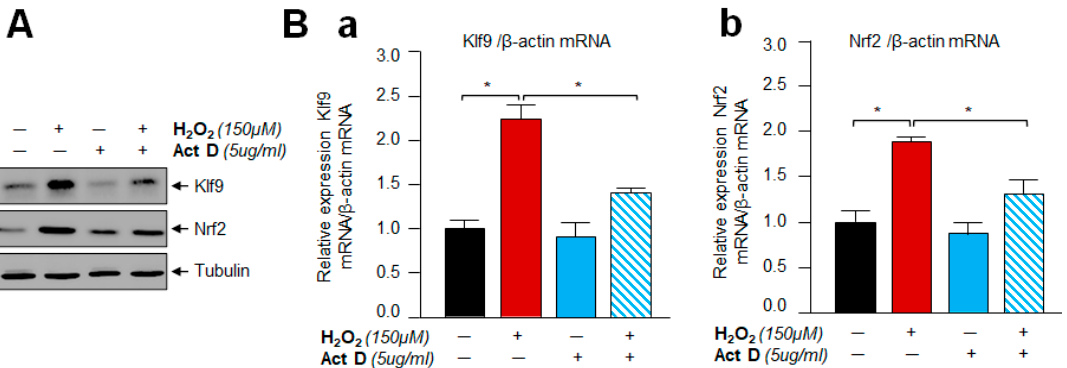
Figure 10. Actinomycin D treatment revealed that Klf9 induction by oxidative stress did not occur post-transcriptionally. ( A , B ) hLECs were pretreated with Actinomycin D (Act D) for 30 min followed by H 2 O 2 for 3 h and proceeded for protein ( A ) and mRNA ( B ) analysis with Klf9 ( Ba ) or Nrf2 ( Bb ) specific probes as indicated. Data are the mean ± S.D. of three independent experiments. * p < 0.001 vs. control.